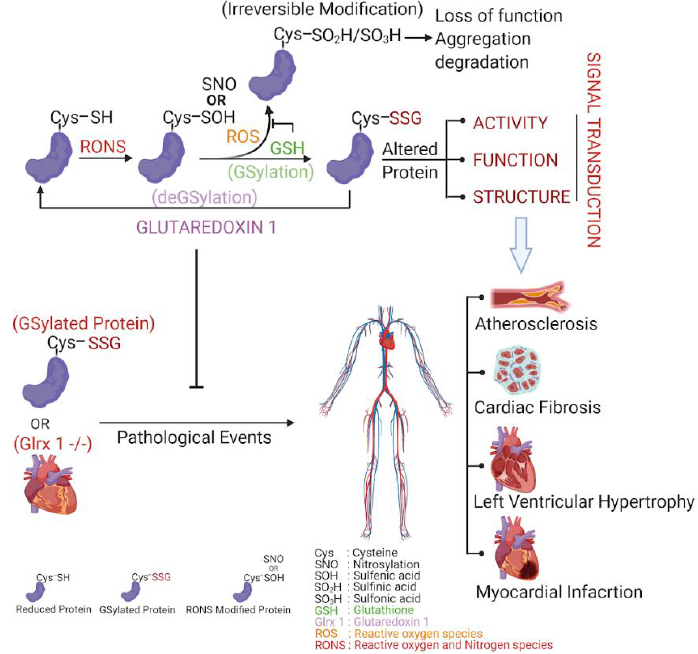
Figure 2. GSylation, deGSylation and its pathological events. Protein cysteines are readily oxidized by RONS as reversible S-OH or S-NO. While these modifications are unstable / short lived, they are prone to irreversible modifications like HSO 2 / HSO 3 . The cell’s reducing environment tries to protect these cysteines from irreversible modifications. GSH, being one of the most abundant reductants of cells, protects protein cysteines by making GSH adducts through a process termed GSylation. While GSylation can alter the function, structure, and activities of proteins which a ff ects signal transduction, Glrx 1 can reduce proteins by specifically removing GSH adducts called deGSylation. Hence, GSH and Glrx 1 maintains GSylation and deGSylation homeostasis in cells. Accumulation of GSylated proteins due to altered cell signaling or Glrx 1 insu ffi ciency could induce pathological events like atherosclerosis, cardiac fibrosis, left ventricular hypertrophy, and myocardial infarction,